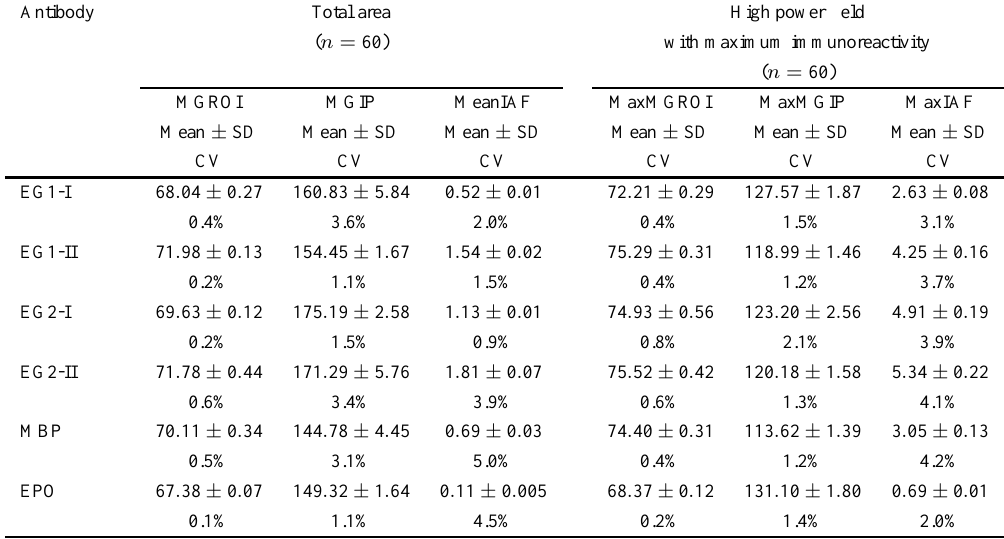
REPIMAGE: Repeated measurements of the same immunostained section of different days